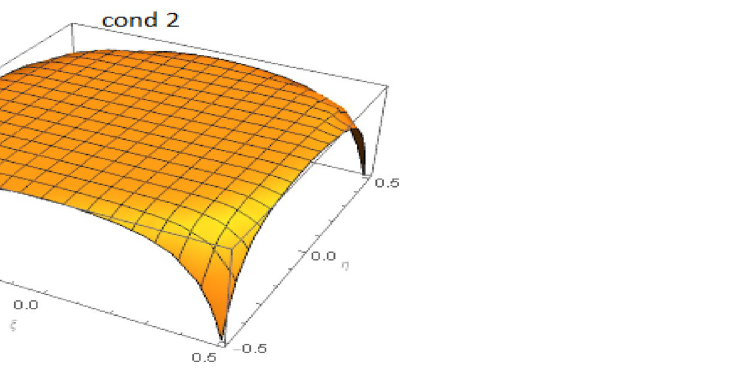
Figure 3. Satisfaction of the second condition for